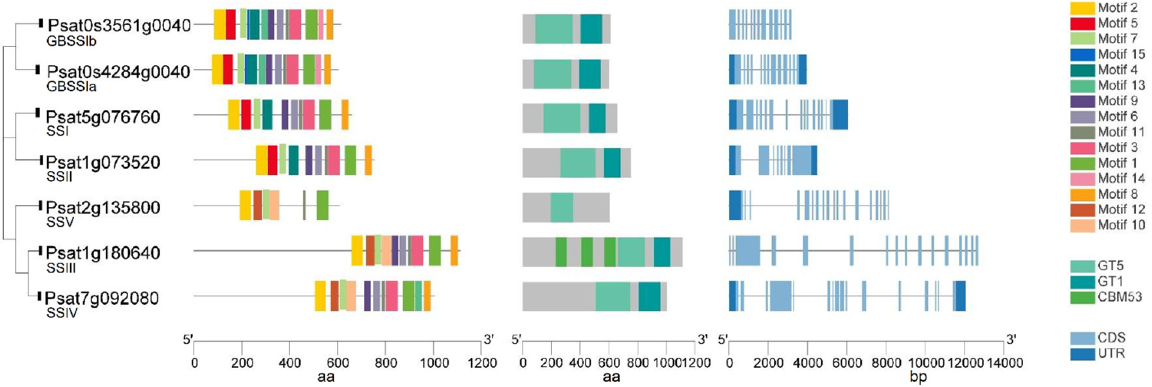
Figure 3. Gene structure, functional domains and conserved motifs in putative granule-bound starch synthase (GBSS) and soluble starch synthase (SS) isoforms in peas. Domains identified are carbohydrate-binding modules of family 53 (CBM53) domain, glycosyltransferase-5 (GT5) domain and glycosyltransferase-1 (GT1) domain.